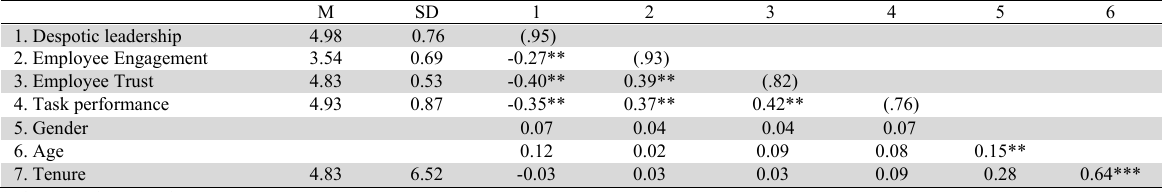
Mean, SDs and correlations of variables